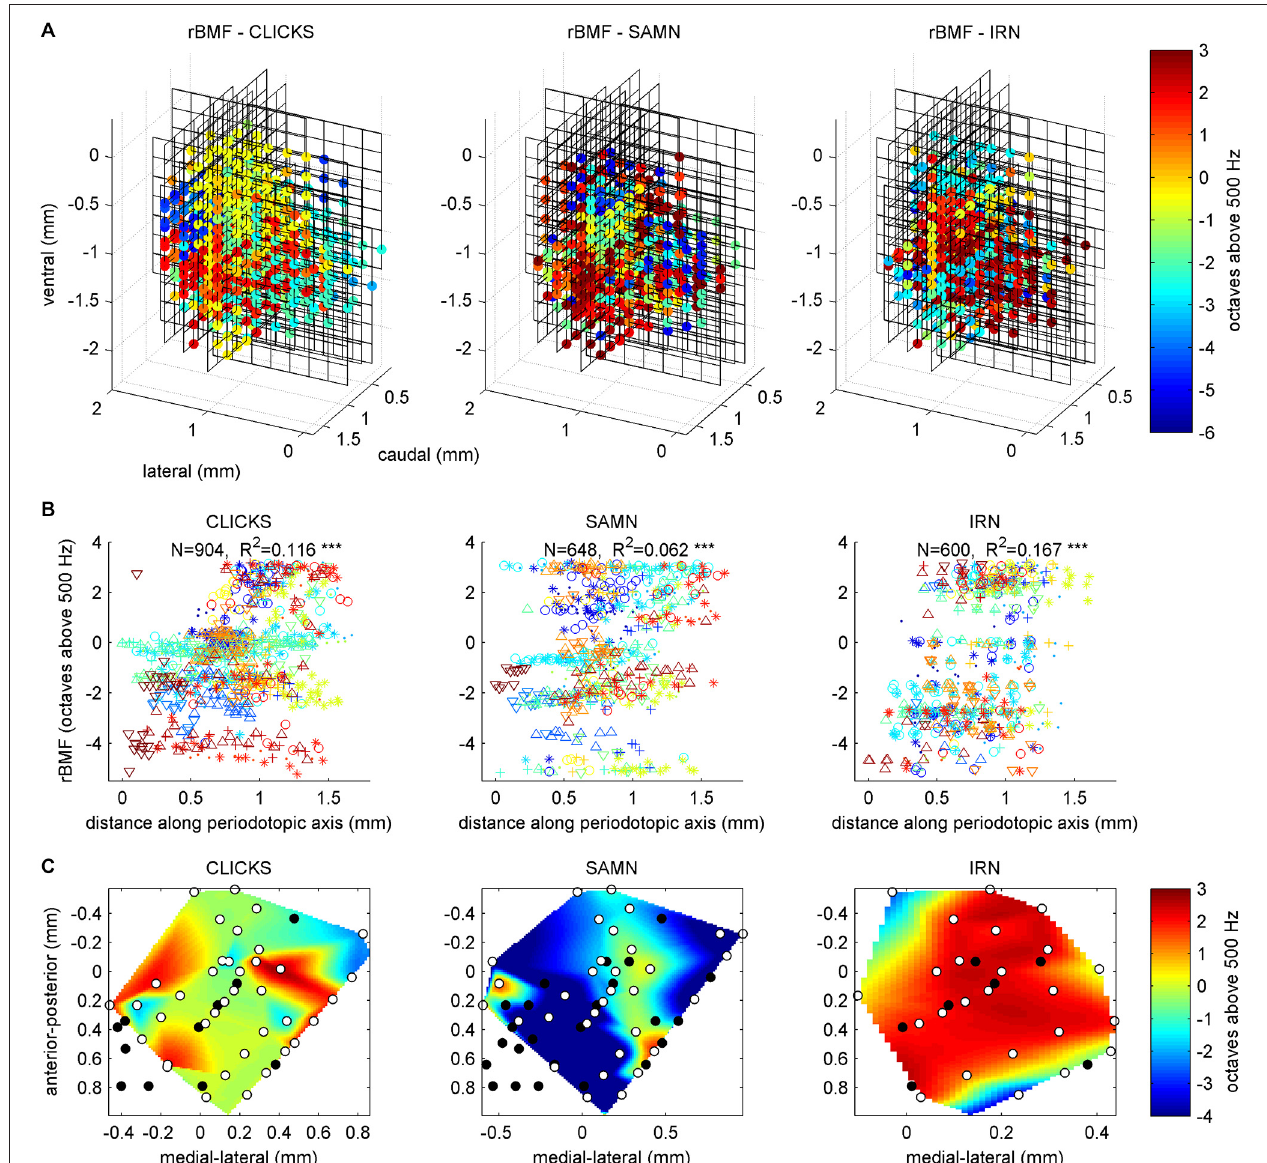
to plot the data recorded from each animal. A random Gaussian distributed jitter with a standard deviation of 0.09 octaves has been added to the rBMF values to spread out overlapping data points. The number of multiunits in each data set ( N ) and correlation coefficient ( R ) are shown above each panel. Triple asterisks ( ∗ ) indicate that the R values are statistically significant at p < 0.001. (C) Periodotopic maps constructed from multiunits within a functionally defined iso-frequency lamina (BFs within 15% of 1 kHz). The ordinate and abscissa give anatomical distances in mm within the iso-frequency plane. The black dots show the positions of multiunits that were excluded from the analysis because their responses were not strongly influenced by stimulus MF. The white dots show the location of multiunits whose rBMFs were used to construct the periodotopic maps by 2-D